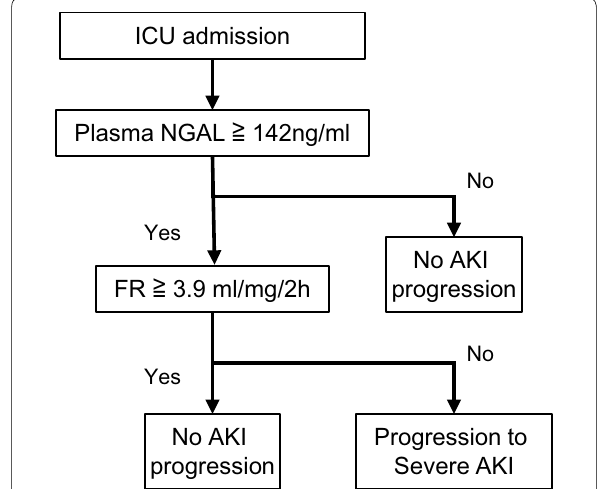
(a) without and with the progression to AKI stage 3 and (b) without and with the progression to AKI stage 3 or death within one week. *, p < 0.01. Figure S2 . prediction of AKI progression by weight-adjusted FR. Receiver operating characteristic curves (ROC) in (a) progression to AKI stage 3 and (b) progression to AKI stage 3 or death at one week.